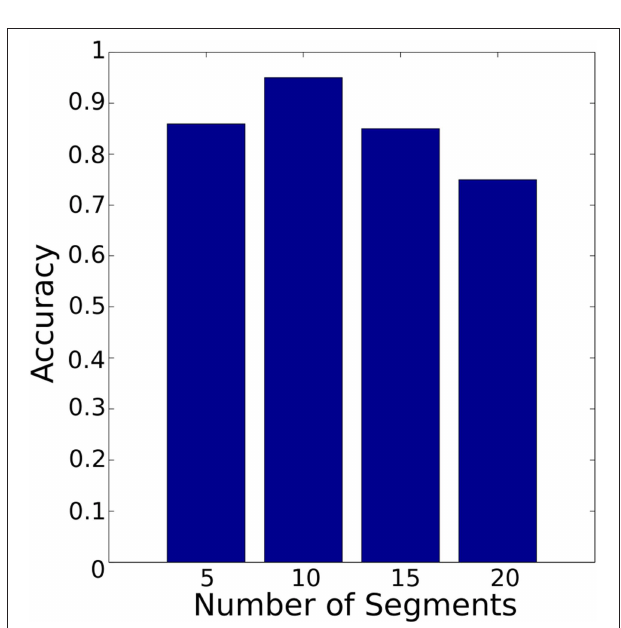
FIGURE 14 | Classifier accuracy with PAA segmentation using different number of segments. The best accuracy was achieved with 30 segments.